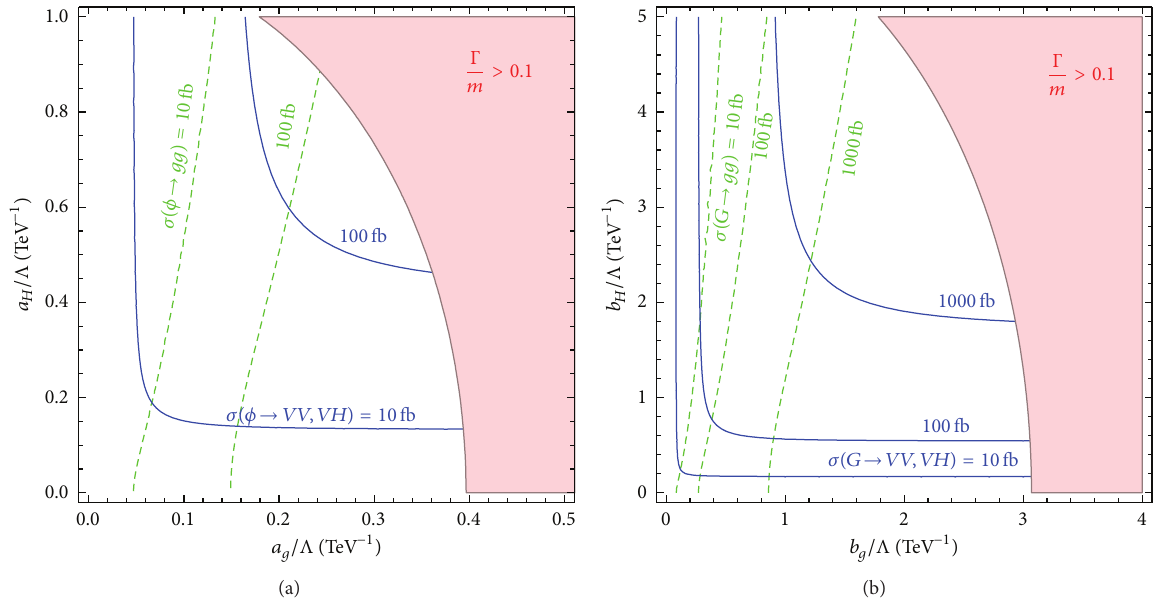
Figure 2: Total cross sections at 8TeV LHC for the spin-zero (a) and spin-two (b) hypothesis in the 𝐻𝑉 and 𝑉𝑉 channels and digluon final state. Note that cross sections do not include efficiencies to